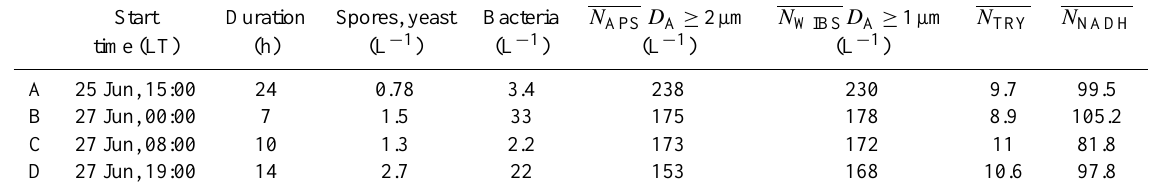
Table 1. Filter sample times and durations, ELPI concentration results and corresponding WIBS and APS mean number